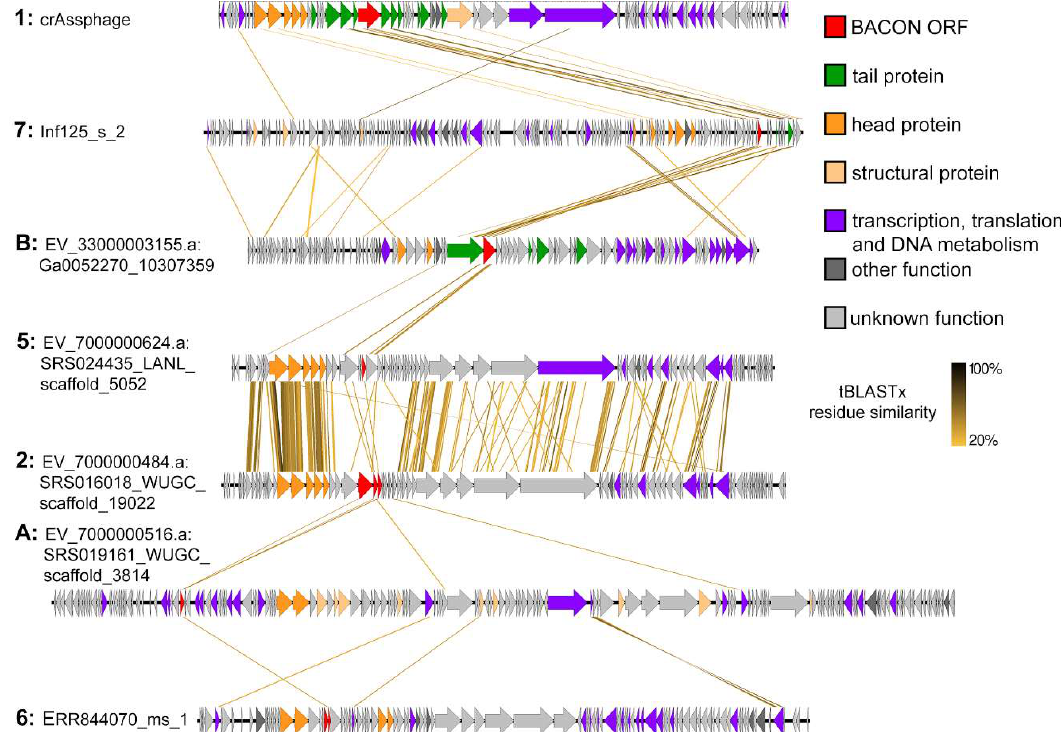
Figure 4. Whole genome comparisons of selected contigs from each phage cluster show that horizontal transfer has occurred in the neighbourhood of crAss-BACON ORFs between the otherwise unsimilar clusters 1, 7 and B. crAss-BACON tandem repeated proteins in these clusters are located in the tail section of the genome. In all clusters except from B, head proteins are those proteins that were identified in the phylogenetic analysis in Figure 2c.